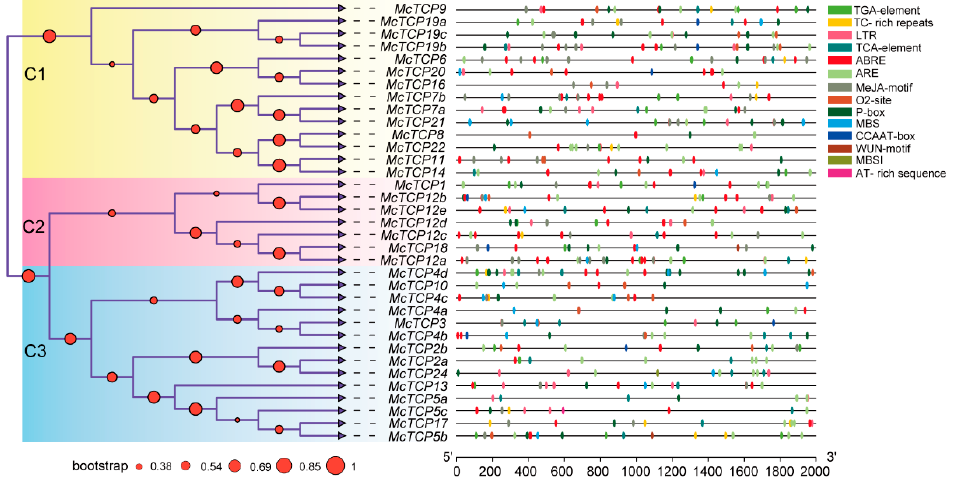
Figure 4. Promoter analysis of TCP family members. The red dot on branches of the phylogeny trees denotes bootstrap value. Different color models on the black lines mean elements of